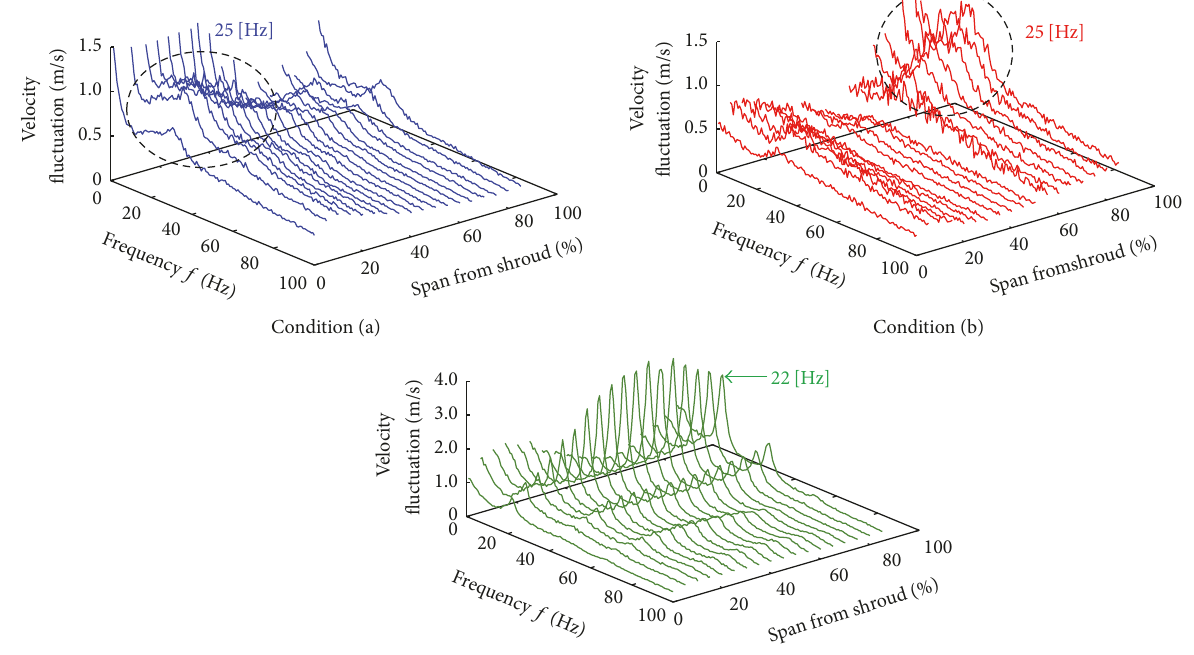
Figure 16: Distribution of velocity fluctuation in spanwise direction on three conditions (a) ∼ (c).